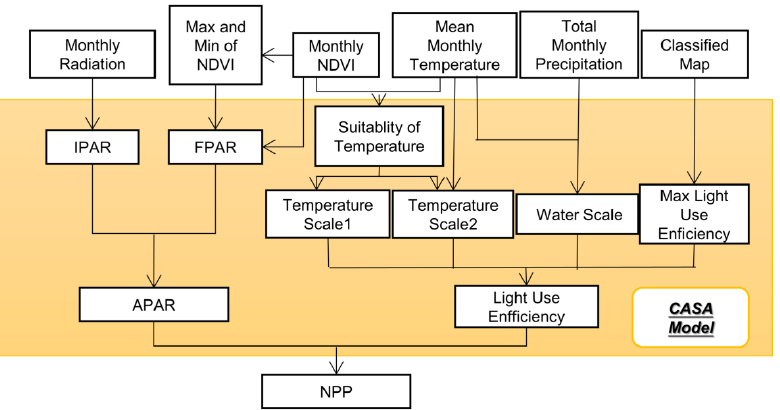
Figure 4. Flowchart of estimating NPP using the CASA model, where IPAR denotes the intercepted photosynthetically active radiation, FPAR represents the fraction of absorbed photosynthetically active radiation, and APAR is the absorbed photosynthetically active radiation.